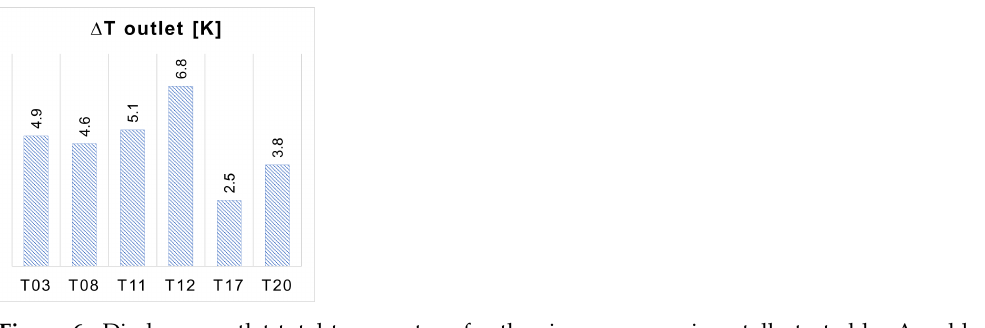
Figure 6. Discharge outlet total temperature for the six cases experimentally tested by Ansaldo Energia